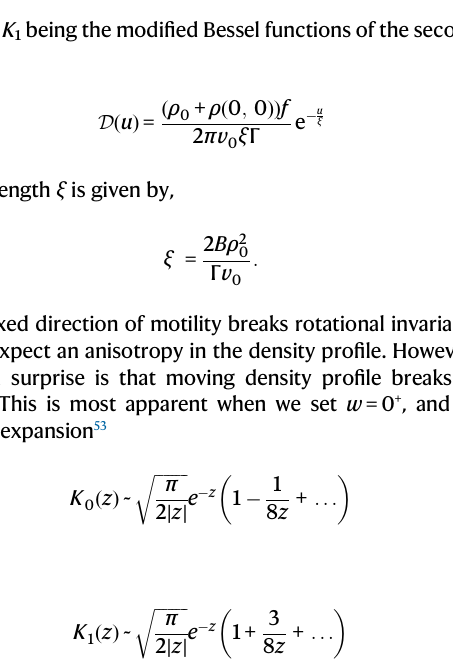
Fig. 5 | Verifying hydrodynamic equations by coarse-graining agent-based simulations. A Simulation snapshot of the x – y con fi gurations showing an active particle at the origin (black dot) surrounded by particles comprising the com- pressible medium. We compute the coarse-grained fi elds, ρ ( r , t ), v ( r , t ) and their spatial derivatives in the shaded (blue) annular region and the thin shaded (black) rectangularregion (Supplementary Note 3). B To verify (4), we plot v y ( r , t ) vs. ρ ∂ y ρ intheblue-shadedregionin A atagiventime;thebest- fi tline(dashedline)givesthe parameter B / Γ =4.29±0.093.(inset)Usingthisvalueof B / Γ ,wecompute v x ( r , t )and ρ vs. x along the thin black rectangular region in A and fi nd good agreement. ρ ∂ x